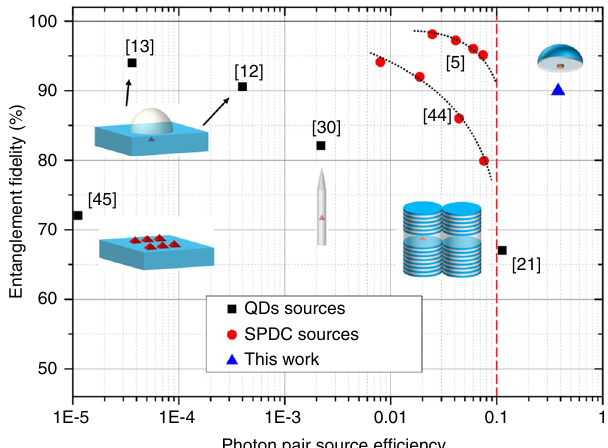
Fig. 4 Comparison with other QD and SPDC entangled photon sources. State-of-the-art results, in terms of entanglement fi delity and source ef fi ciency, on several different types of QD sources are shown as black symbols. High quality SPDC entangled photon sources are shown as red symbols, see also the work by Jöns et al. 30 . Red dashed line indicates the ef fi ciency limit of SPDC sources. The performance of the current device is shown as a blue triangle in the upper right corner, marking the highest combination of source brightness and entanglement fi